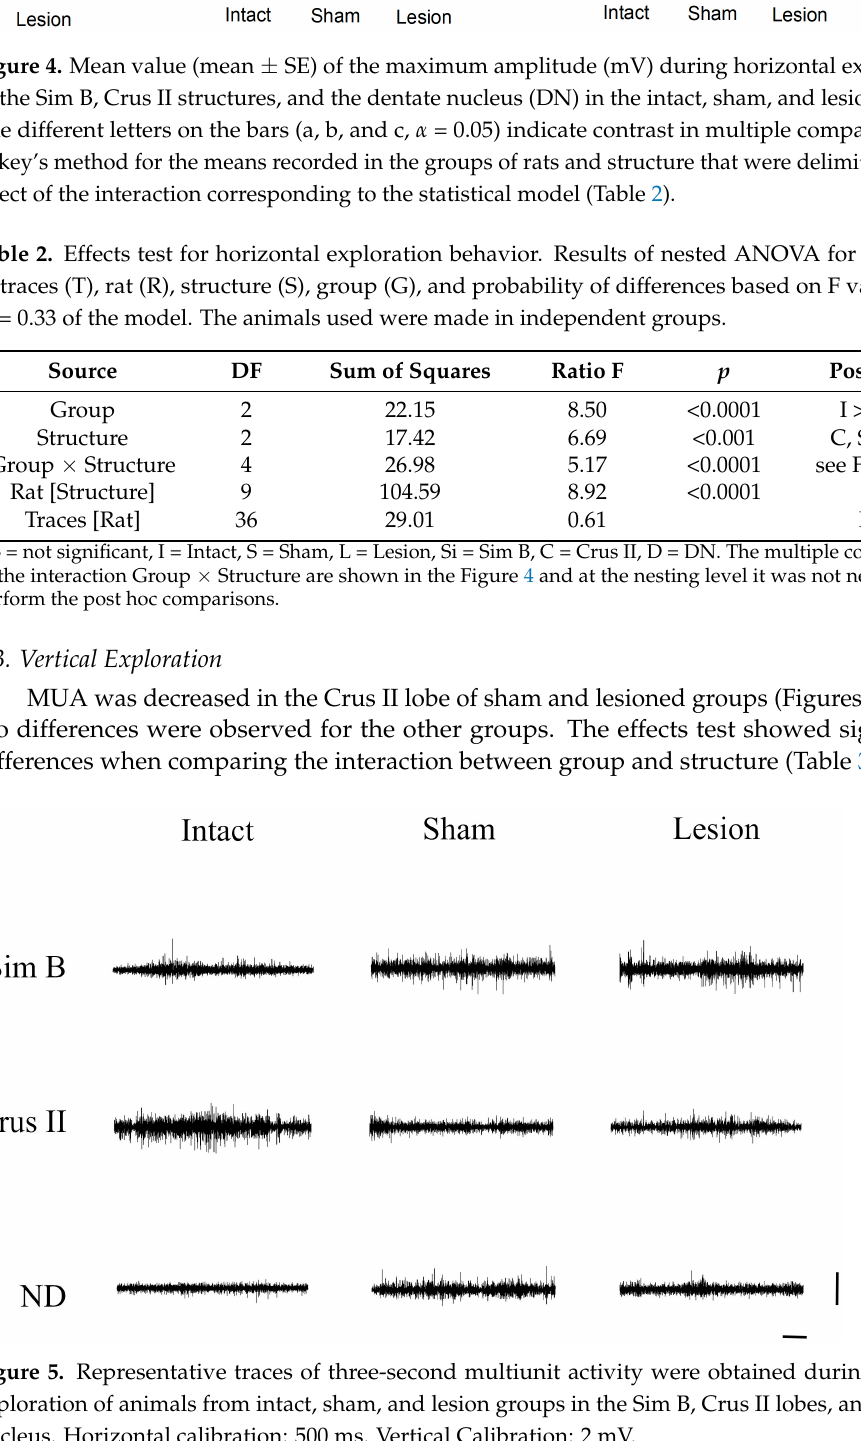
Figure 6. Average value (mean ± SE) of the maximum amplitude (mV) during vertical exploration of the Sim B, Crus II structures, and the dentate nucleus in the intact, sham, and lesion groups. The bifferent letters on the bars (a, b, and c, α = 0.05) contrast in multiple comparisons by Tukey’s method for the means recorded in the groups of rats and structure that were delimited by the effect of the interaction corresponding to the statistical model (Table 3). Table 3. Effects test for vertical exploration behavior. Results of nested ANOVA for the effect of traces (T), rat (R), structure (S), group (G), and probability of differences based on F values and r 2 = 0.32 of the model. The animals used were made in independent groups. Source